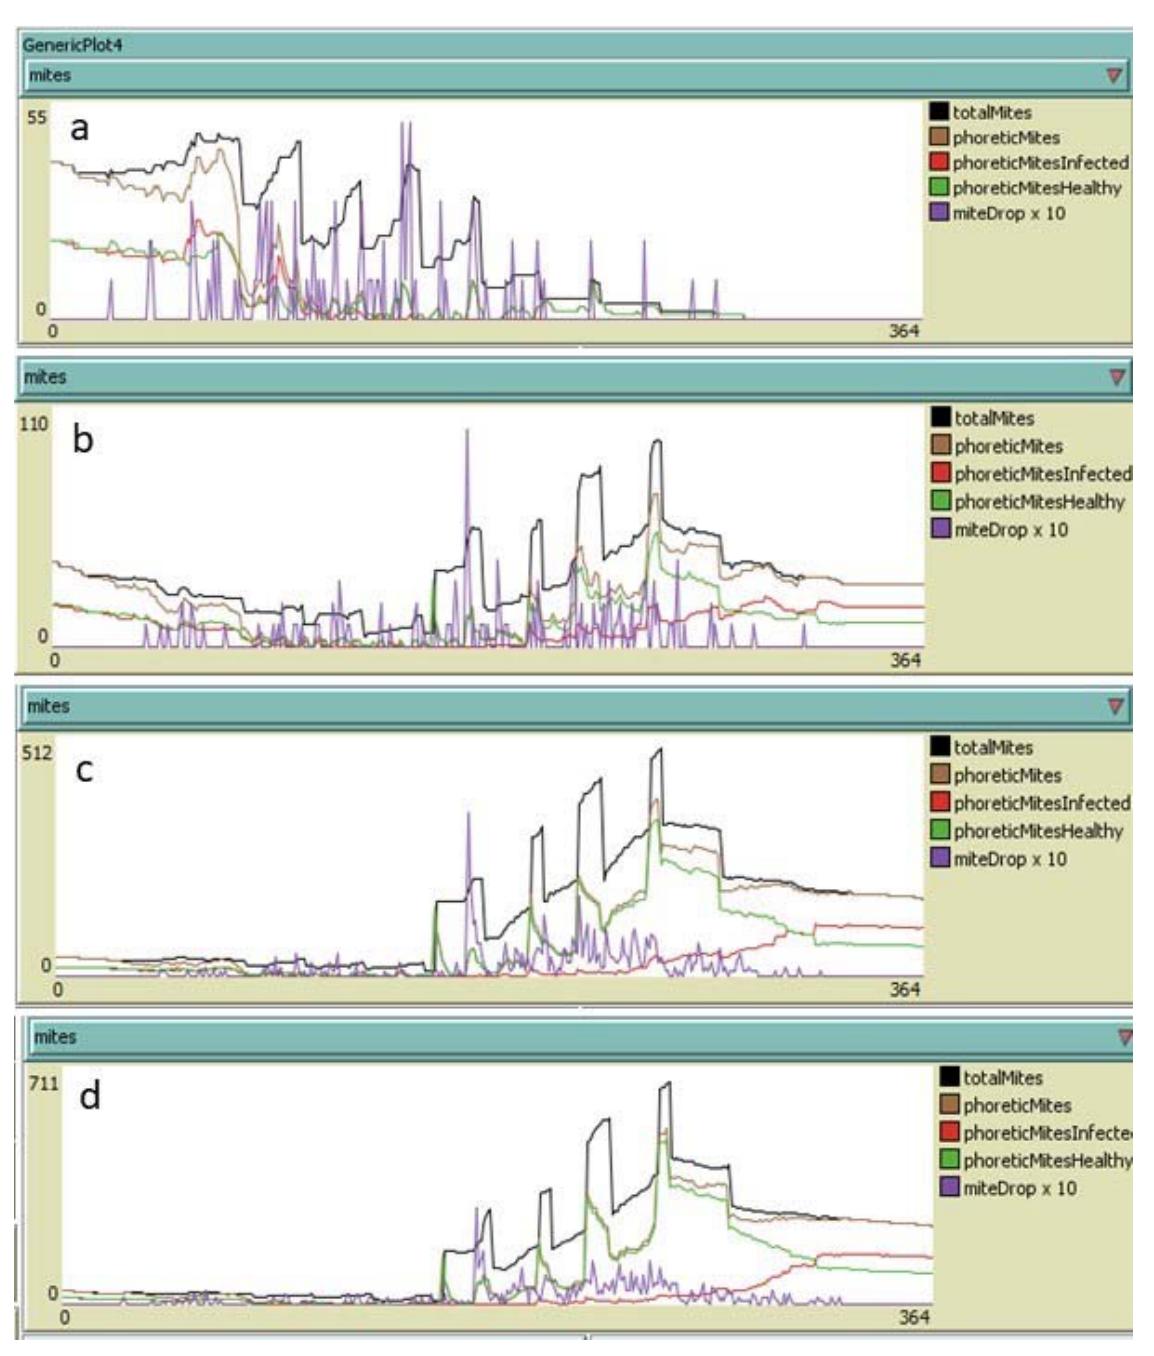
Figure 9. Yearly development of Varroa destructor infestation in colonies subjected to nine heat treatments under different hypotheses of re-infestation: ( a ) no re-infestation; ( b ) 30 mites per month from June to September (120 mites in total); ( c ) 150 mites per month from June to September (600 mites in total); ( d ) 150 mites per month in June and July and 250 mites per month in August and September (800 mites in total). Adult mites alive on 31 December: ( a ) 0; ( b ) 120; ( c ) 158; ( d ) 242. By adopting an integrated control approach (hyperthermia and summer treatments with oxalic acid), the simulations predicted very low levels of infestation at the end of the year, even in the presence of heavy re-infestation phenomena (Figure